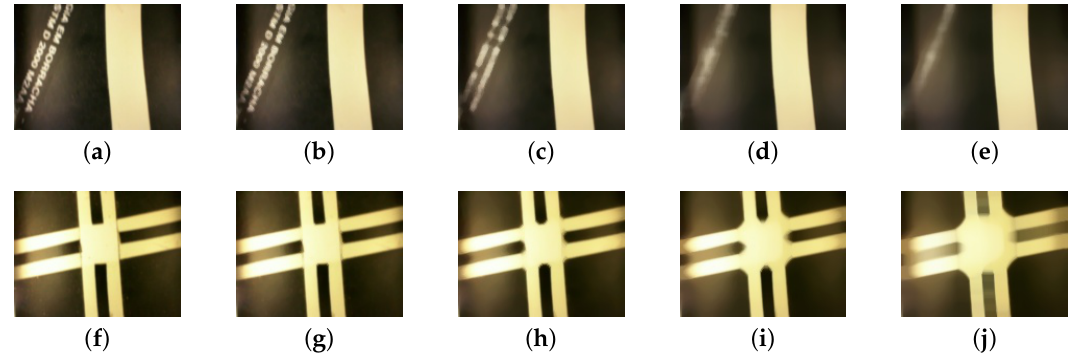
Figure 9. The effect of increasing kernel size in median filter. The first row, images from ( a ) to ( e ), show the filter effect on the reference line with some noise around. The second row presents the effect on the lane crossing. ( a , f ) original image without filtering; ( b , g ) kernel size: 3 × 3; ( c , h ) kernel size: 7 × 7; ( d , i ) kernel size: 15 × 15; ( e , j ) kernel size: 21 ×